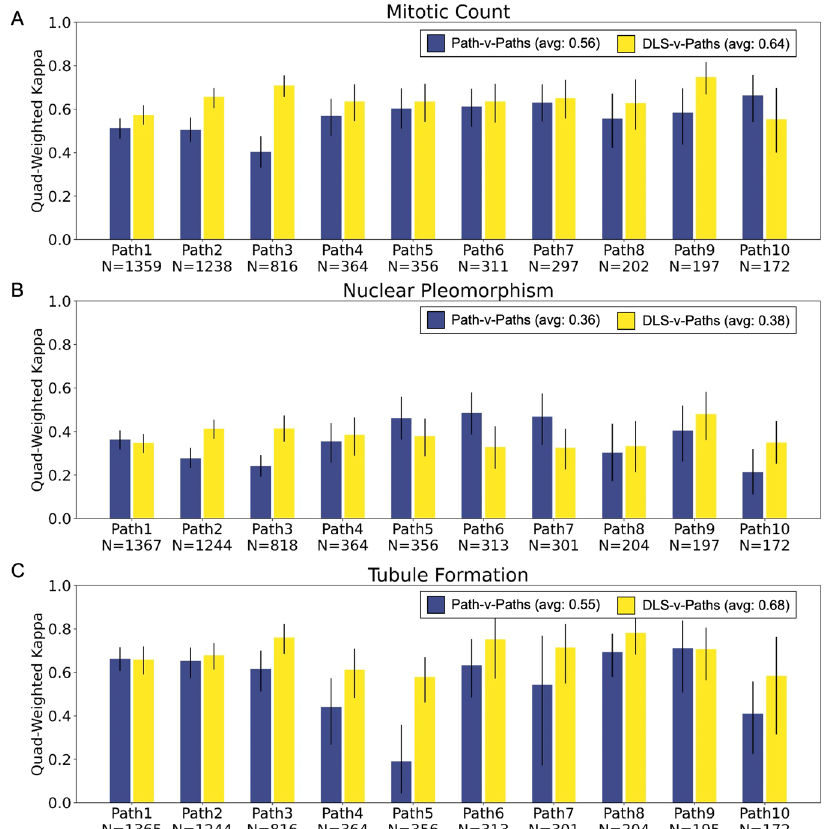
Fig. 4 Inter-pathologist and DLS-pathologist concordance for slide-level component scoring. Analyses for mitotic count ( A ), nuclear pleomorphism ( B ), and tubule formation ( C ) are shown in the individual panels. Each blue bar represents the agreement (quadratic-weighted kappa) between a single pathologist and the other available pathologist scores on the same cases. The yellow bar represents the agreement of the DLS-provided component score with all available pathologist ’ scores on the matched set of cases. Error bars represent 95% con fi dence intervals computed via bootstrap. Average values in legend represent quadratic-weighted kappa or the average of all blue bars and yellow bars, respectively. DLS deep learning system, Paths pathologists. Table 3. Prognostic performance of direct risk prediction using histologic scoring provided by DLS and